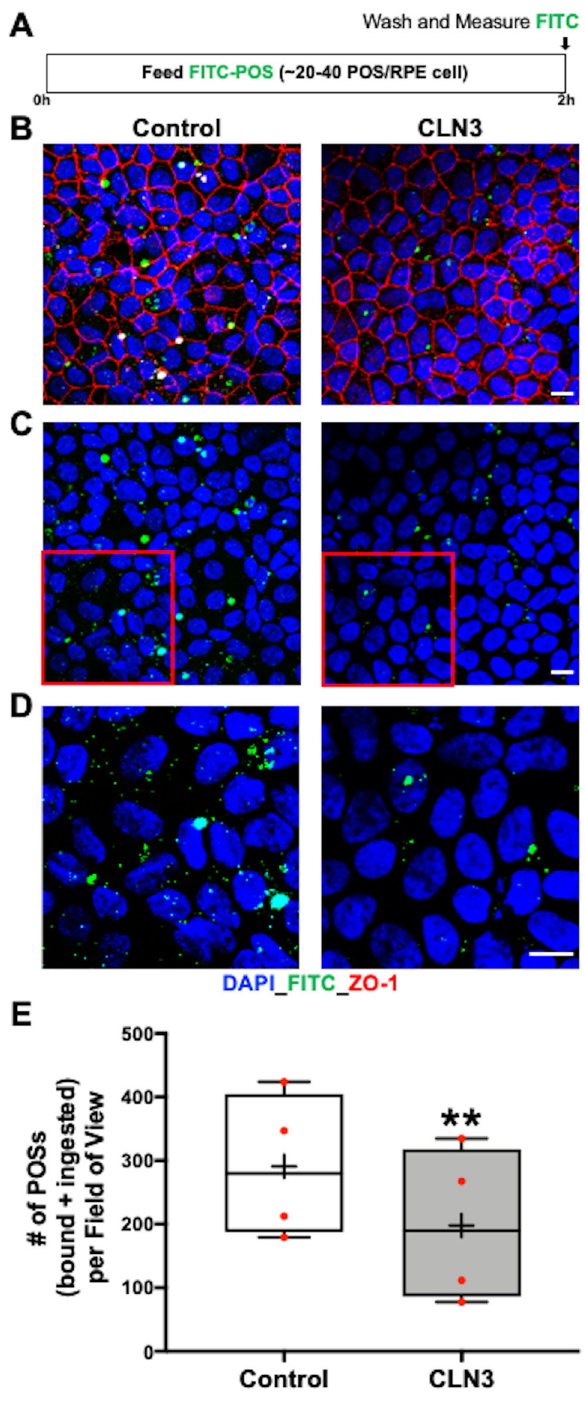
showed ~6.43-fold higher amount of CLN3 in the transduced hiPSC-RPE cells (Supplementary Fig. 10). Of note, we did not observe a difference in the size of endogenous versus over- expressed CLN3 protein by Western blot analyses as in hiPSC- RPE cells transduced cells with bi-cistronic pHIV-MYC-CLN3- IRES-EGFP vector, the CLN3 and EGFP are translated separately within the single mRNA at the IRES. Consistent with our immunocytochemical data (Fig. 7A, B), Western blot analyses of the RPE microvilli versus cell pellet fraction showed the presence of ( i ) CLN3 in both the